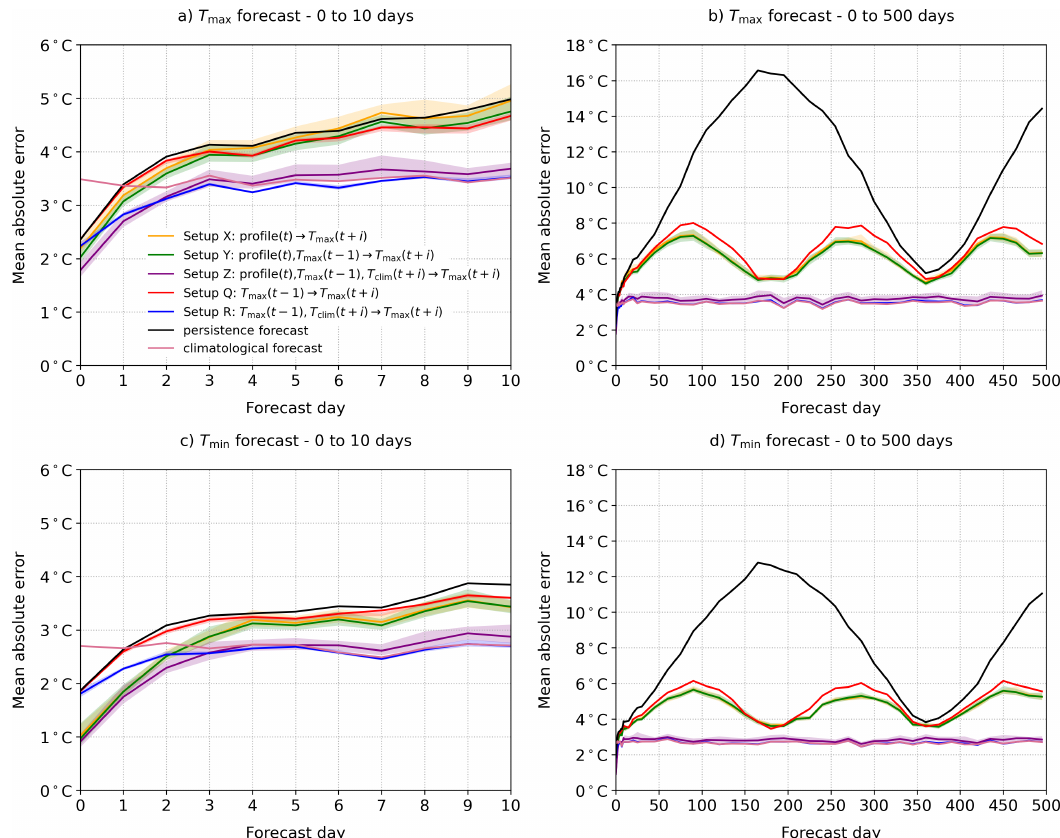
Figure 5. The evolution of the test set mean absolute error (MAE) for forecast using various NN setups. The setups are described in Table 3. The time index t refers to the day of the radiosonde measurement, with t − 1 referring to the previous day, and t + i to the i -th day in the future. The legend is the same for all subfigures as long as T max in ( a , b ) is replaced with T min in ( c , d ). For the forecasts made by various NN setups, the lines represent the average MAE values in the ensemble while the color shaded regions indicate the interval between the 10th and 90th